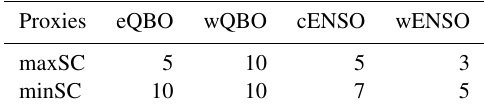
Table 2. Summary of the number of years considered in the com- posite analyses with SC, QBO, and